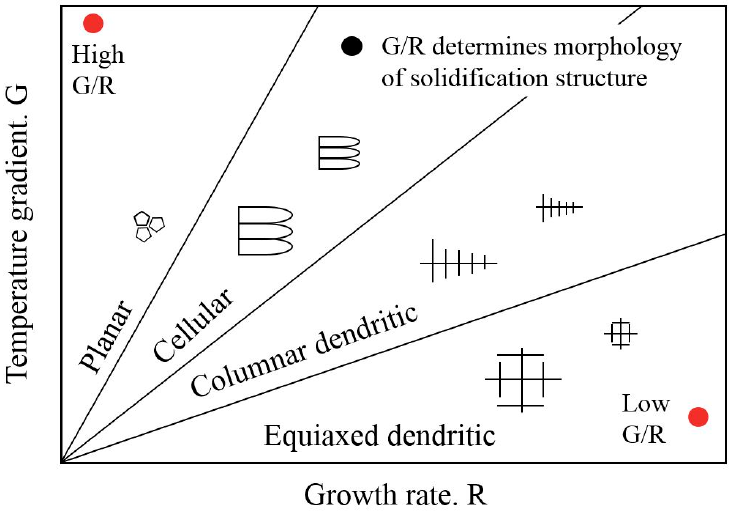
Figure 7. The relationship between G and R and their effect on morphology of solidification struc ‐ ture [20].